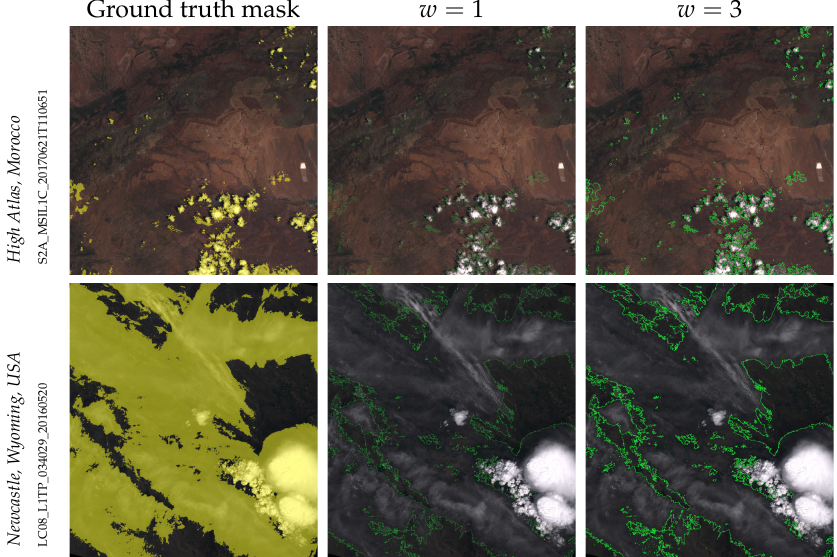
Figure 6. The first column shows the RGB composite, with cloudy pixels highlighted in yellow, for a Sentinel-2 and a Landsat-8 image. The second and third columns show the excluded pixels in green around cloud edges for w = 1 and w = 3,